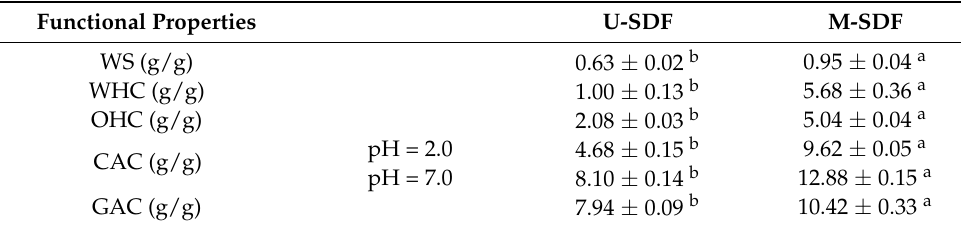
Table 2. The effect of fermentation on the SDF functional